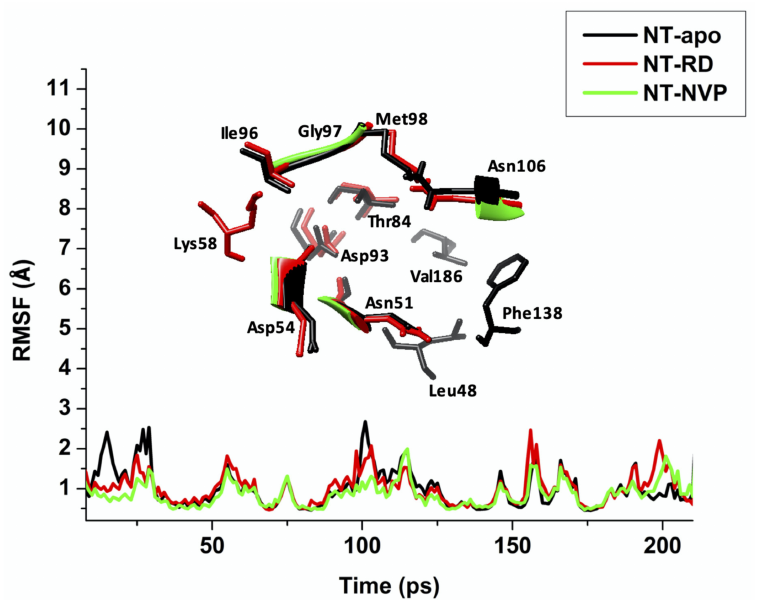
Figure7. AverageC- α fluctuationsexperiencedbyresiduesoftheapo, RDandNVPboundconformation of Hsp90 throughout the 200,000 ps MD